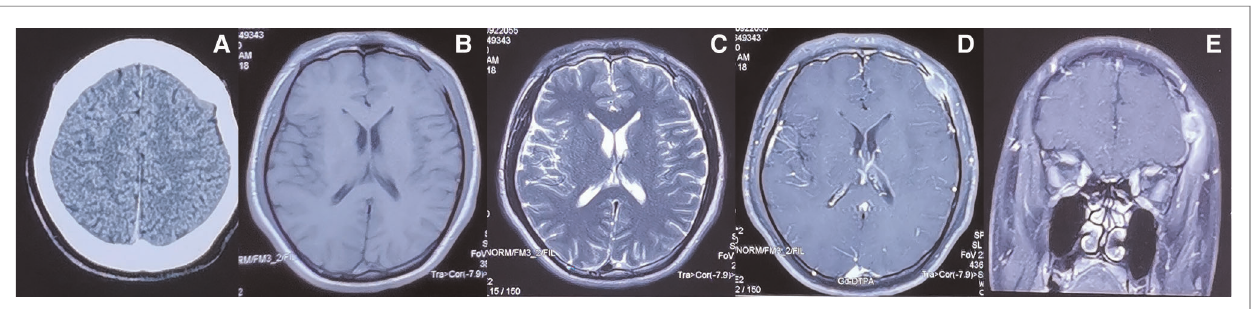
FIGURE 1 | Preoperative imaging information of LCS ( A ) Computed tomography and ( B – E ) magnetic resonance imaging fi ndings of the intracranial and extracranial communication lesions in the left